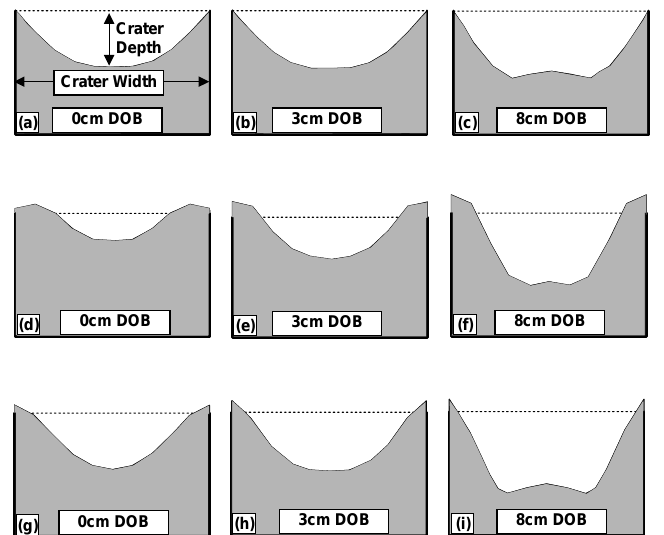
Fig. 9. Effect of the Depth of Burial (DOB) on the crater shape obtained: (a)–(c) experimentally in Ref. [4]; (d)–(f) computationally using original compaction model for sand; (g)–(i) computationally using the modified compaction model for sand. Explosive weight and type: 0.1 kg C4; Sand type: − 30/ + 50 mesh silica sand; DOS: